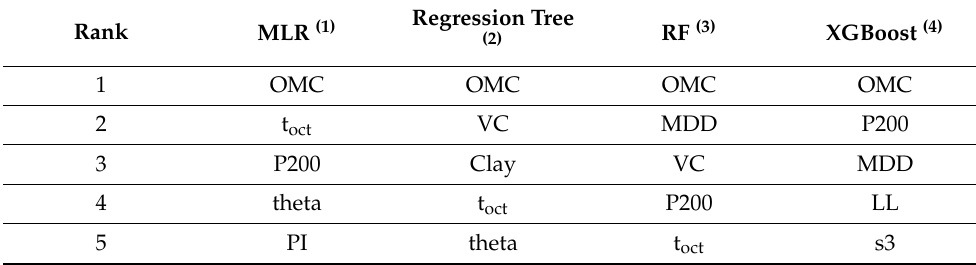
Table 6. Comparison of variable importance across